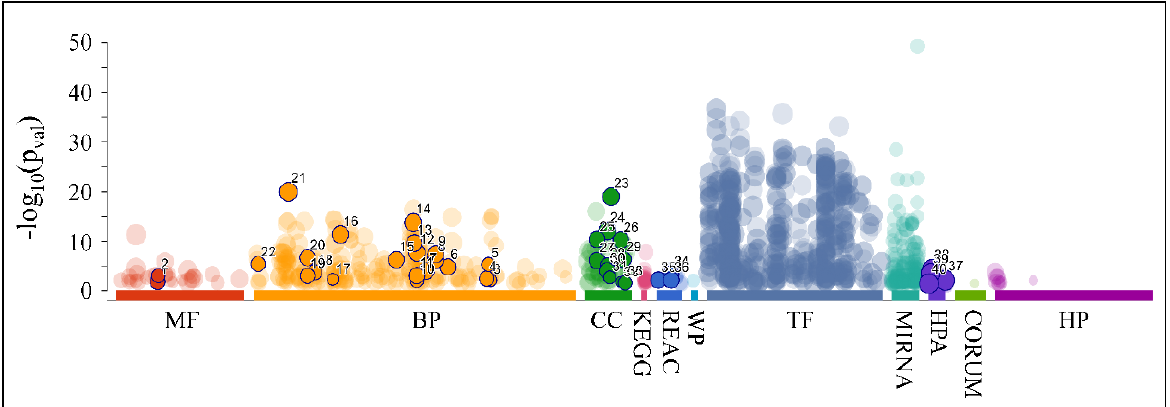
Figure 15. Functional annotation of the predicted mRNA targets for the co-downregulated miRNAs: MIR149, MIR214, MIR574, MIR595 and MIR765 (Legend: MF: Molecular Function, BP: Biological Process, CC: Cellular Component, KEGG: KEGG pathway database, REAC: Reactome pathway database, WP: WikiPathways, TF: Transcription Factor Binding Motifs, MIRNA: MiRNA Targets, HPA: The Human Protein Atlas, CORUM: The Comprehensive Resource of Mammalian Protein Complexes, HP: Human Phenotype Ontology). Table 4. The respective functional annotation of the predicted mRNA targets for the co-downregulated miRNAs: MIR149, MIR214, MIR574, MIR595 and MIR765. The colors correspond to the annotation colors presented in Figure 14 (Legend: MF: Molecular Function, BP: Biological Process, CC: Cellular Component, KEGG: KEGG pathway database, REAC: Reac- tome pathway database, HPA: The Human Protein Atlas).